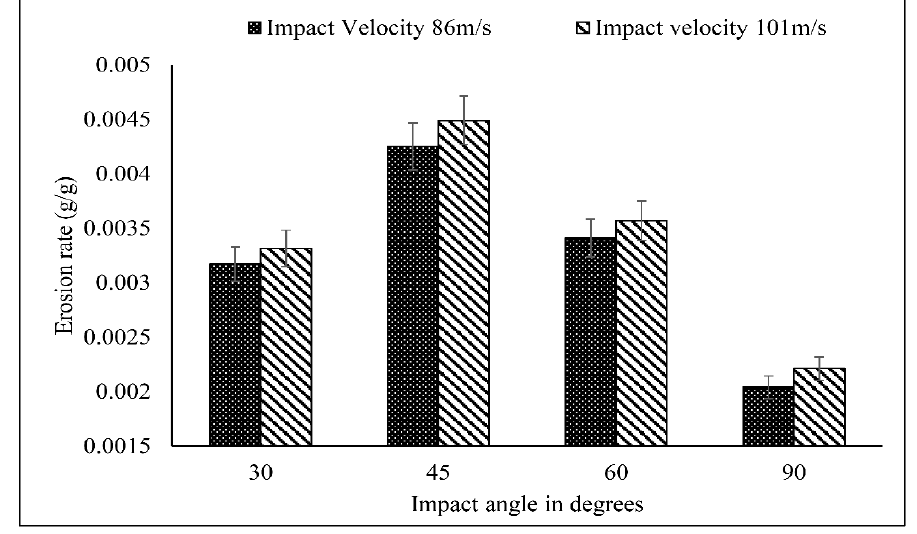
Figure 6. Erosion rate for 2wt% of filler nanocomposites at an impact velocity of 86m/s and 101m/s